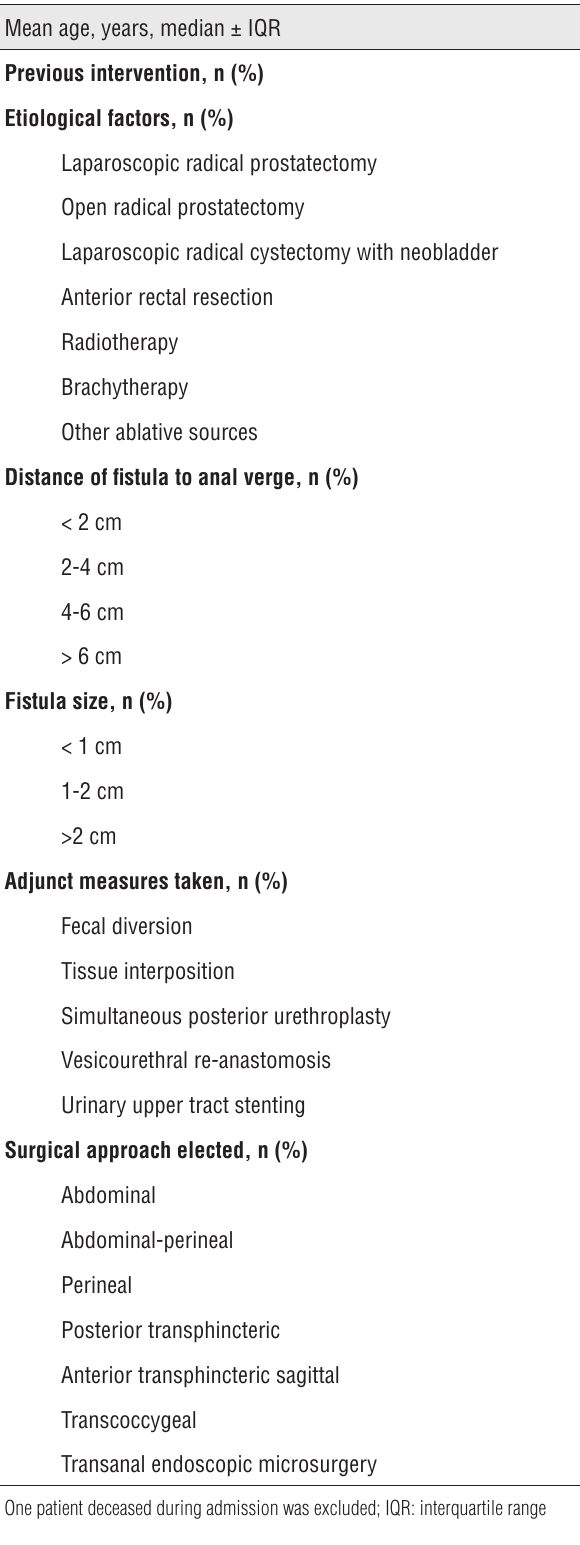
Table 1 - Main characteristics of patients (n=38)